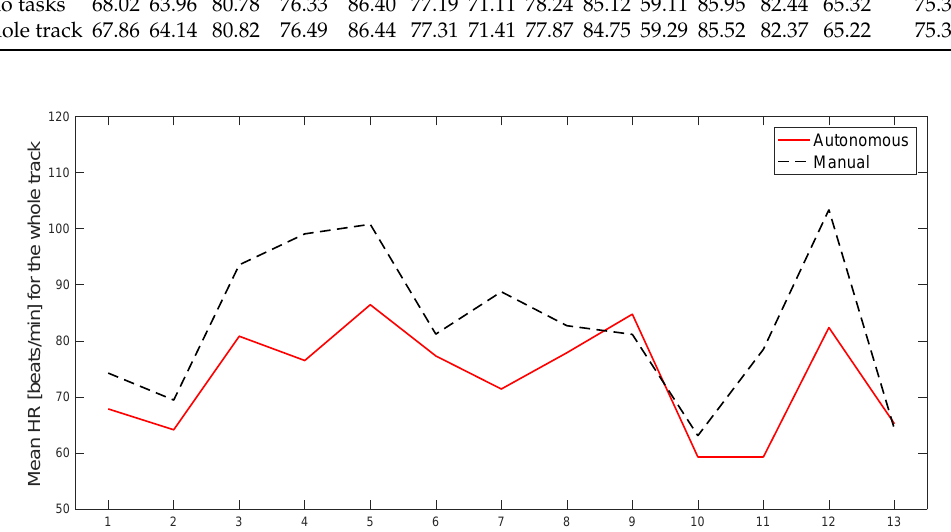
Figure 14. Mean value of the HR for all of the subjects during the whole track, in both autonomous and manual